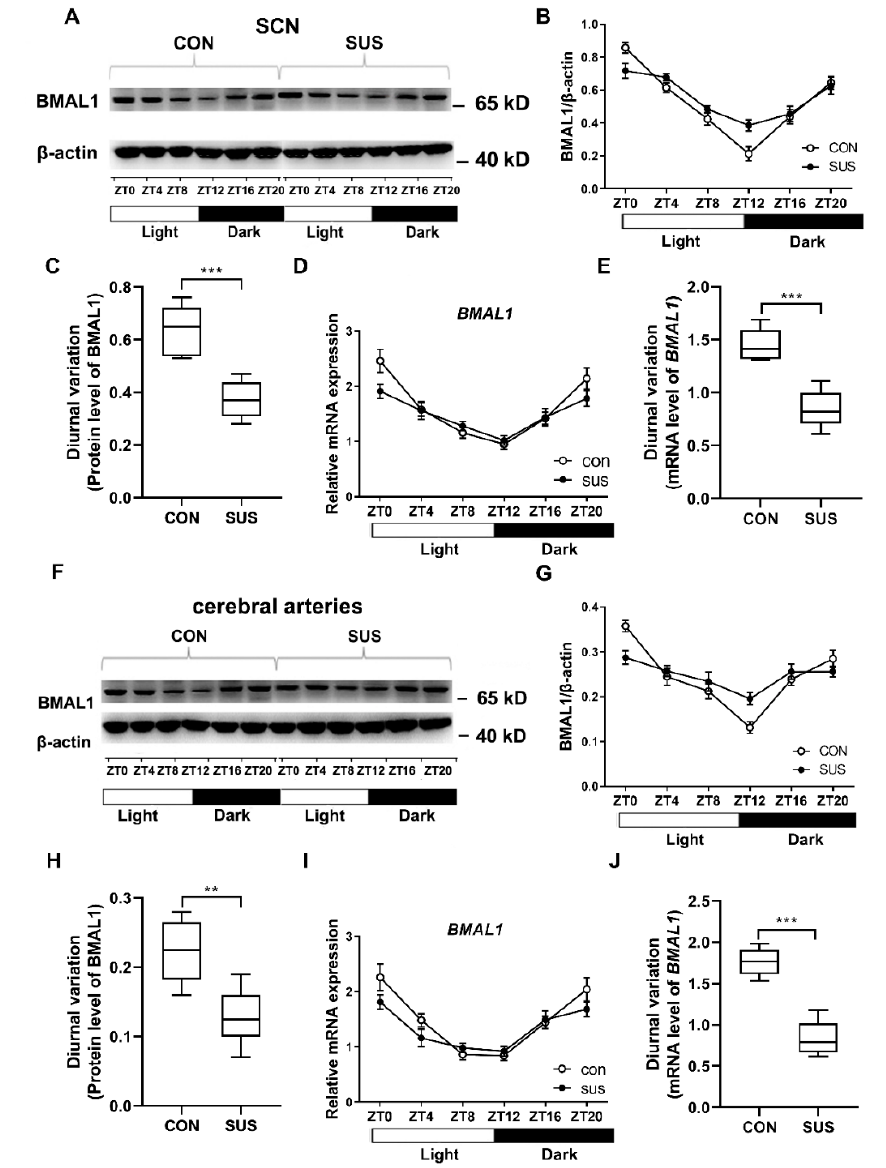
Figure 5. Circadian expression of clock gene BMAL1 in suprachiasmatic nuclei (SCN) and cerebral arteries isolated from CON and SUS rats at six di ff erent time points. ( A ) The representative protein expressions of BMAL1 in SCN are shown. The mean data of BMAL1 protein ( B ) and mRNA ( D ) expression in SCN display a circadian oscillation. The diurnal variation in BMAL1 protein ( C ) and mRNA ( E ) expression (the di ff erence value between ZT0 and ZT12 level) in SCN significantly decreased in SUS rats as compared with that in CON rats. ( F ) The representative protein expressions of cerebrovascular BMAL1 are shown. The mean data of cerebrovascular BMAL1 protein ( G ) and mRNA ( I ) expression display a circadian oscillation. The diurnal variation in cerebrovascular BMAL1 protein ( H ) and mRNA ( J ) expression (the di ff erence value between ZT0 and ZT12 level) significantly decreased in SUS rats as compared with that in CON rats. Data are presented as box plots and 5th and 95th percentiles. n = 6, t -test or two-way ANOVA and Tukey’s multiple comparisons test, ** p < 0.01, *** p < 0.001 as compared with CON. CON: 28-day simultaneous control rats; SUS: 28-day tail-suspended rats (the full-length Western blots for Figure 5A,F are shown in the Supplementary